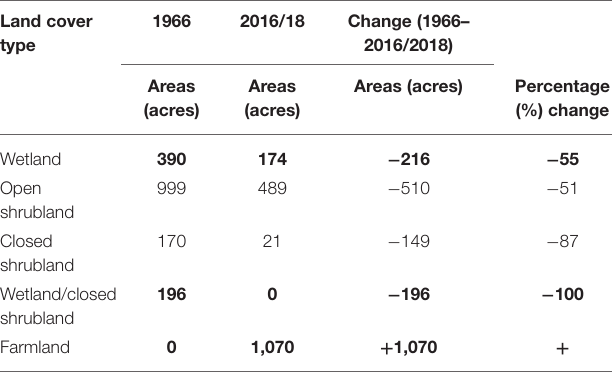
TABLE 2 | Land use/cover changes in Anyiko wetland and its surrounding between 1966 and